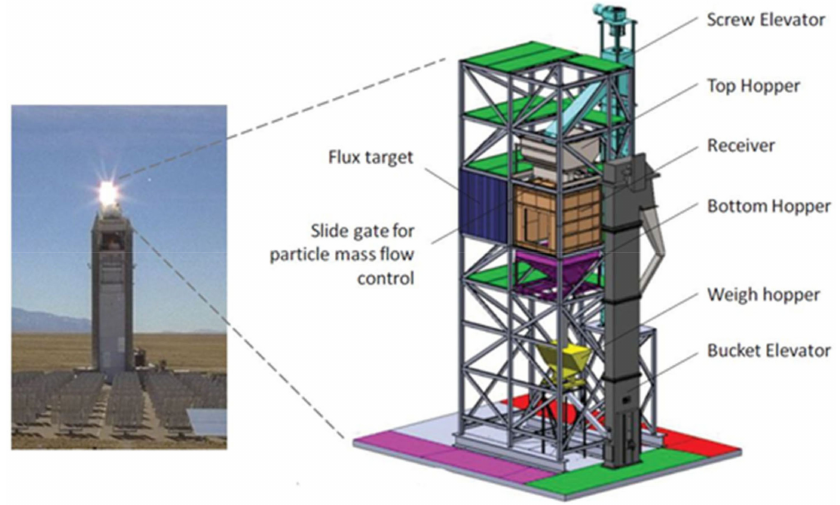
Figure 2. The 1 MW th falling particle receiver system at the National Solar Thermal Test Facility in Albuquerque, NM